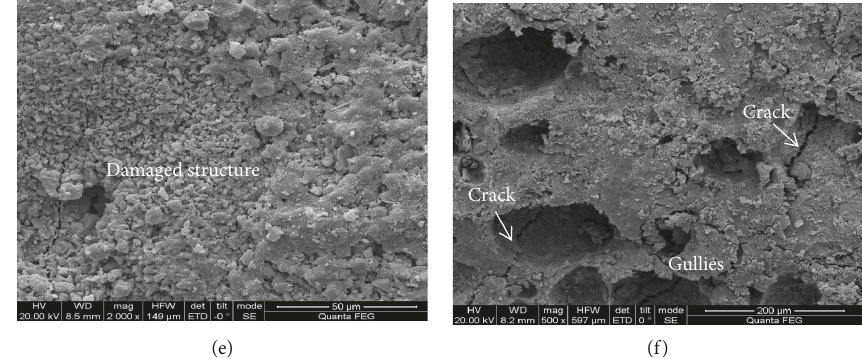
Figure 12: SEM of Group A2 samples before test and after the fourth alternating cycle period: (a) A2; (b) A2-C; (c) A2-F; (d) A2-CF; (e) A2-FC; (f) A2-FC.